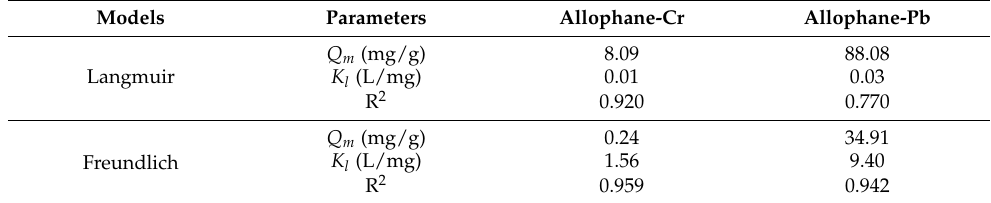
Figure 6. ( a ) Isotherm of CrO 42 − adsorption onto synthetic allophane. ( b ) Isotherm of Pb 2+ adsorption onto synthetic allophane. The dosage of the absorbent was 40 mg/L. Table 1. Isotherm parameters of CrO 42 − and Pb 2+ onto synthetic allophane derived from Langmuir and Freundlich